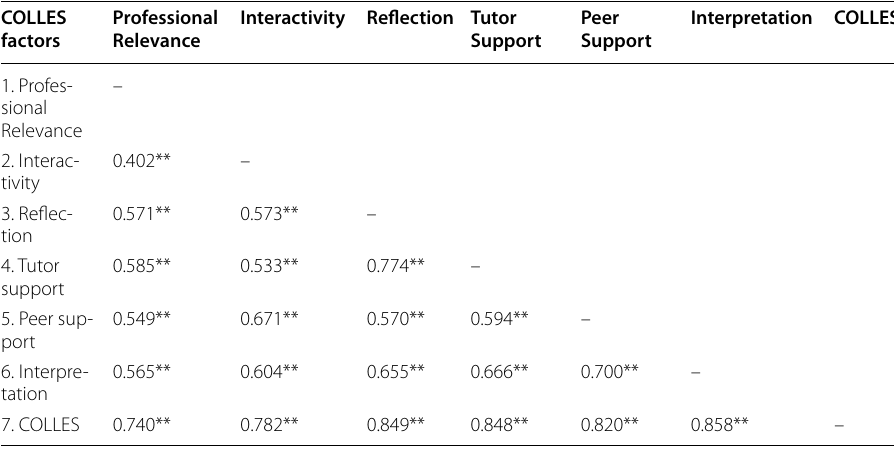
**Correlation is significant at the 0.01 level (2‑tailed)